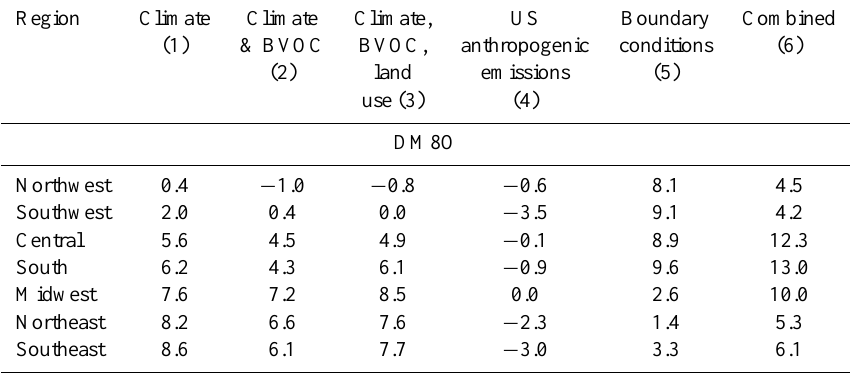
Table 2. Percent change in DM8O between each future scenario and the current decade base case. Region